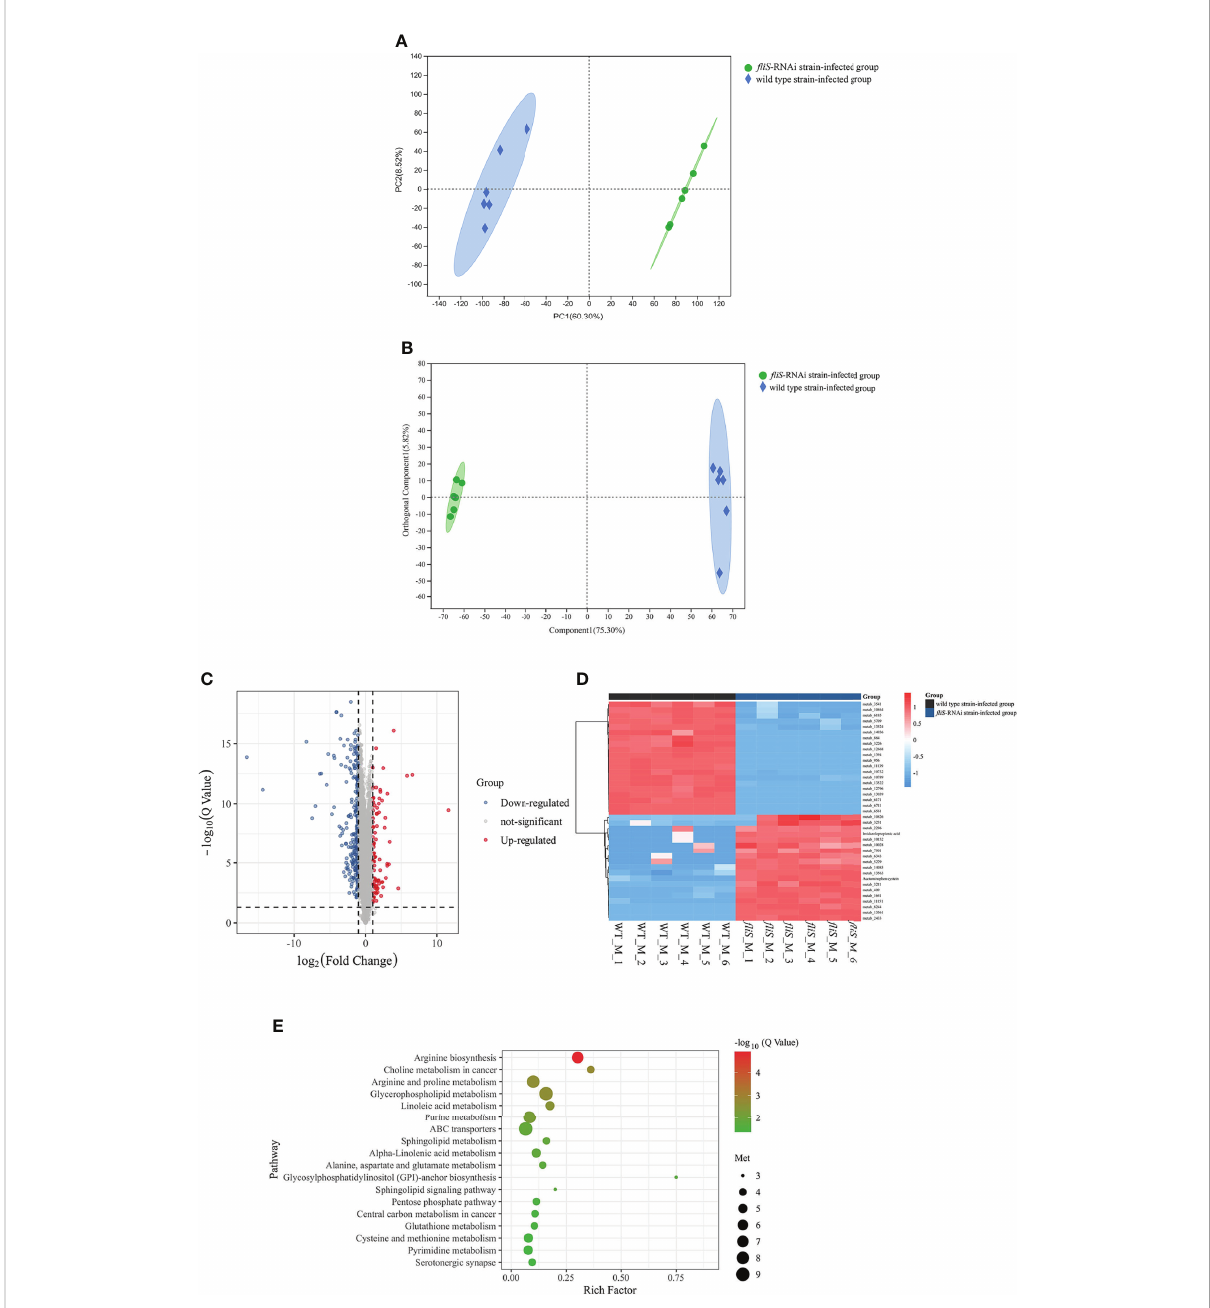
FIGURE 5 Comparative metabolomic analysis of E coioides spleens infected by fl iS -RNAi and wild type strains of P. plecoglossicida . (A) PCA diagram. X- axis shows fi rst principal component, Y-axis shows second principal component. (B) OPLS-DA score plot. Component 1 represents fi rst predictive principal component interpretation and Orthogonal Component 1 represents fi rst orthogonal component interpretation. (C) Volcano plot of differentially expressed metabolites. (D) Heat map comparison of differentially expressed metabolites. (E) KEGG enrichment of differentially expressed